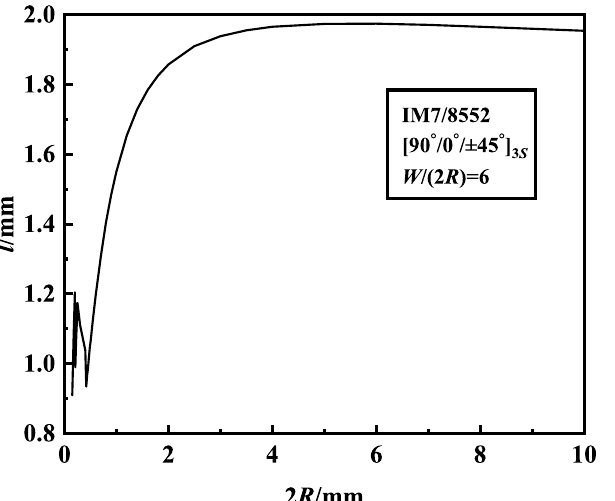
Figure 3. The crack extension at failure of [ 90 ◦ /0 ◦ / ± 45 ◦ ] hole diameters.